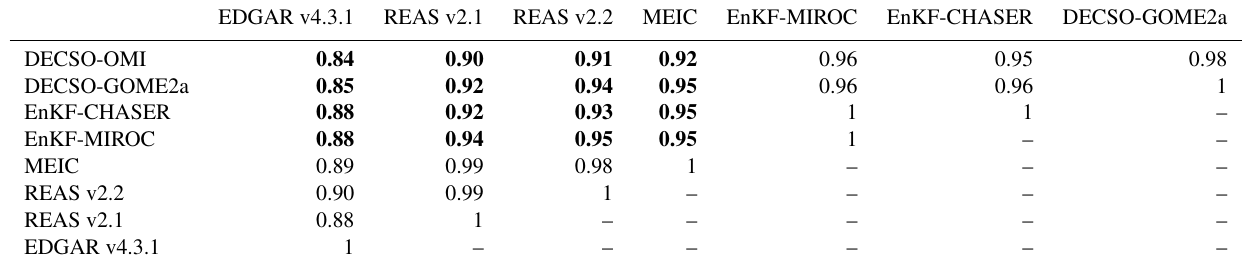
– – – Table 2. Spatial correlation coefficients of annual NO x emissions in 2008 over land on a provincial level in China and other regions outside China. (The total number of provinces and regions is 33, i.e. 29 Chinese provinces, South Korea, North Korea, and parts of Mongolia (83%) and Vietnam (43%); see Fig. 1. The study domain only covers part of the provinces Heilongjiang (74%), Inner Mongolia (83%) and Yunnan (36%).) The bold values indicate the relation between bottom-up and satellite-based